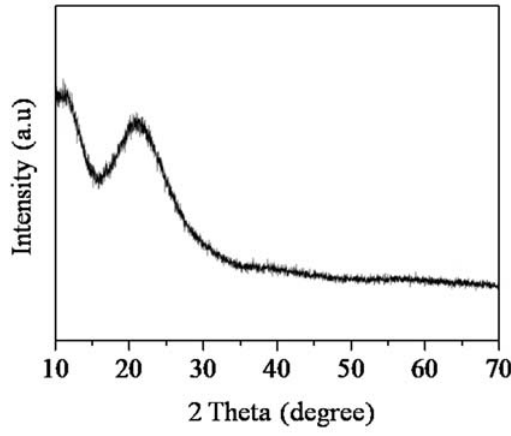
Figure 8. X ‐ ray diffraction (XRD) measurement for SiNS. Figure 8. X-ray diffraction (XRD) measurement for